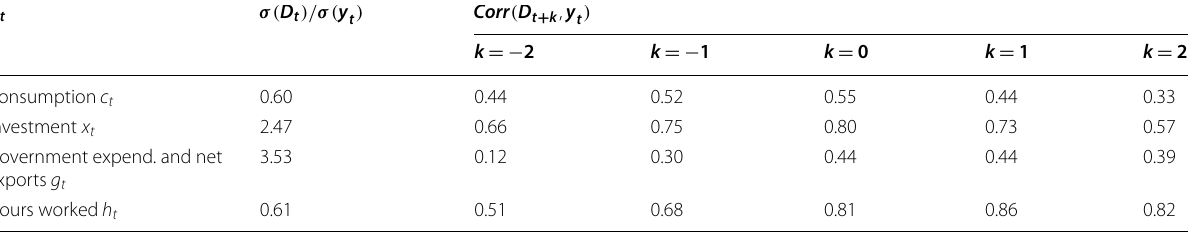
Data are HP-filtered with (cid:31) = 1600